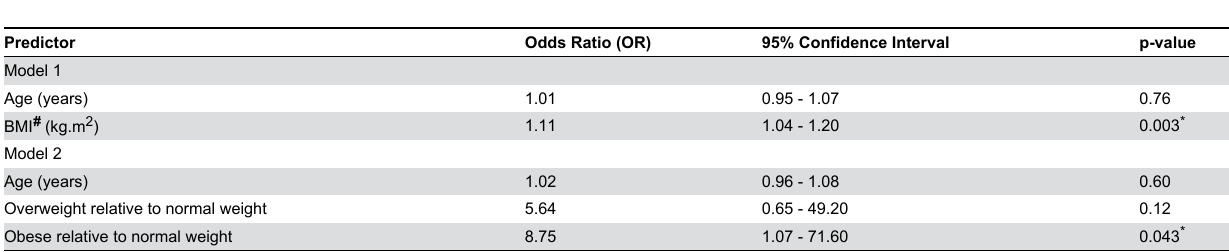
Table 2. Multivariate Analysis of predictors of non-response to recombinant hepatitis B vaccine.